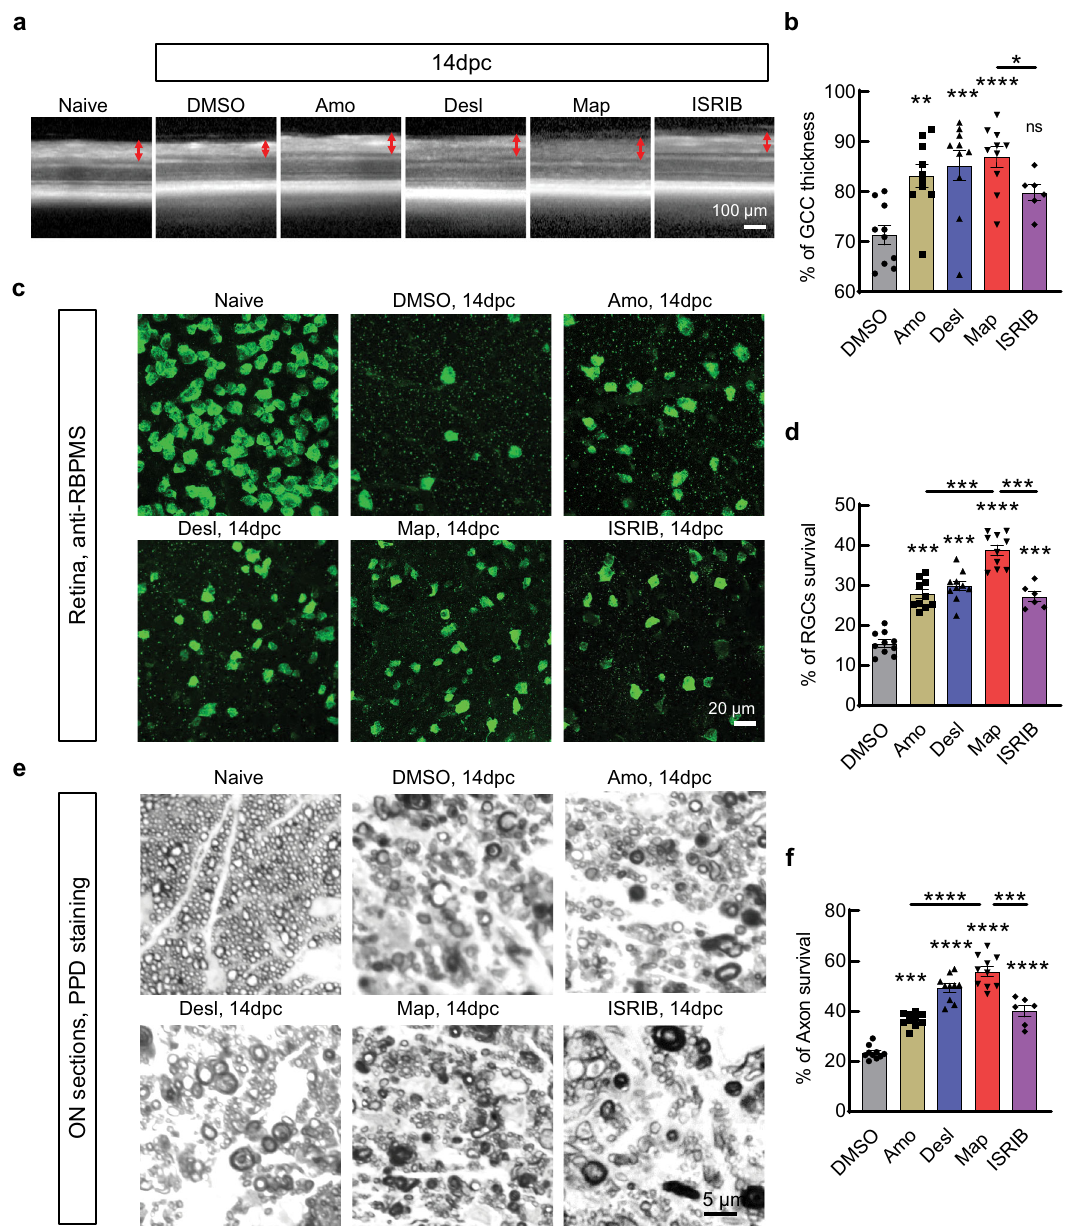
Fig. 4 | In vivo application of the three hit compounds signi fi cantly protects RGCsomataandaxonsaftertraumaticONCinjury.a RepresentativeOCTimages of mouse retina in living animals at 14dpc. GCC: ganglion cell complex, including RNFL, GCL, and IPL layers; indicated as double end red arrows. b Quanti fi cation of GCC thickness measured by OCT at 14dpc, represented as percentage of GCC thickness in the ONCeyes compared to the sham contralateral control eyes. n =10 miceforDMSO,Amo,Desl,andMap; n =6miceforISRIB. c Representativeconfocal images of peripheral fl at-mounted retinas showing surviving RBPMS+(green) RGCs at 14dpc. d Quanti fi cation of surviving RGCs at 14dpc, represented as per- centage of ONCeyes compared to the shamcontralateralcontrol eyes. n =10 mice for DMSO, Amo, Desl, and Map; n =6 mice for ISRIB. e Light microscope images of